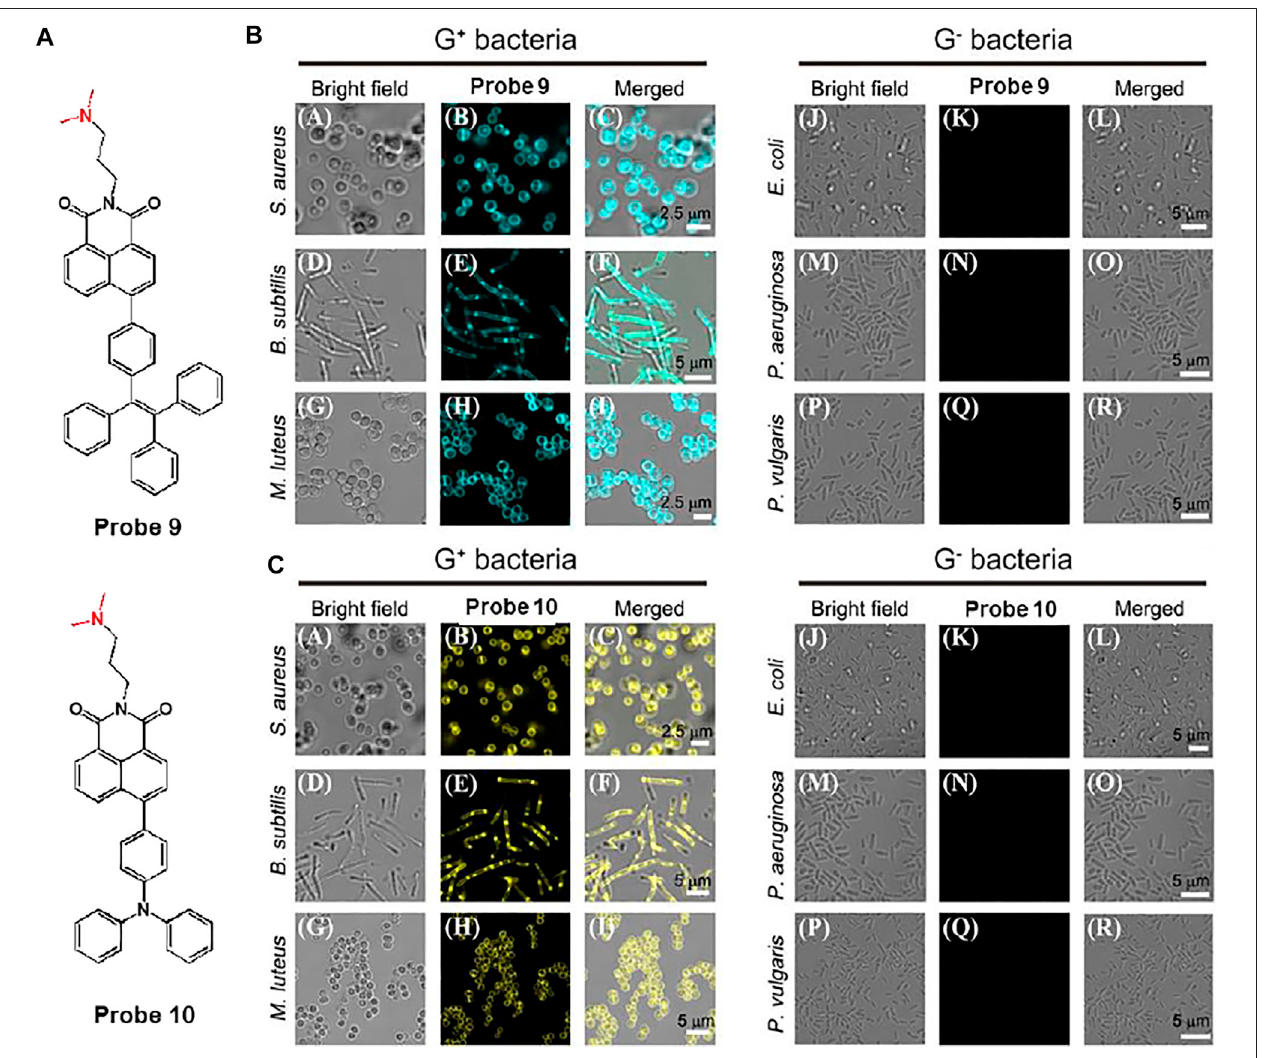
FIGURE 6 | (A) Chemical structures of probes 9 and 10. Confocal microscopic images of Gram-positive (G + ) bacteria and Gram-negative (G − ) bacteria with the treatment of (B) probes 9 and (C) 10, respectively. Reproduced with permission from Sayed et al. (2021). Copyright © 2020, Elsevier.